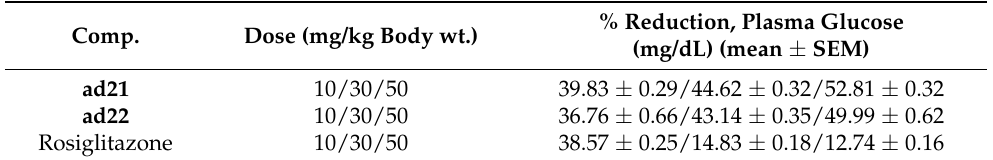
Table 39. Hypoglycemic activity of the compounds ( ad21 – ad22 ) using a streptozotocin-induced diabetic model in rats. Comp.